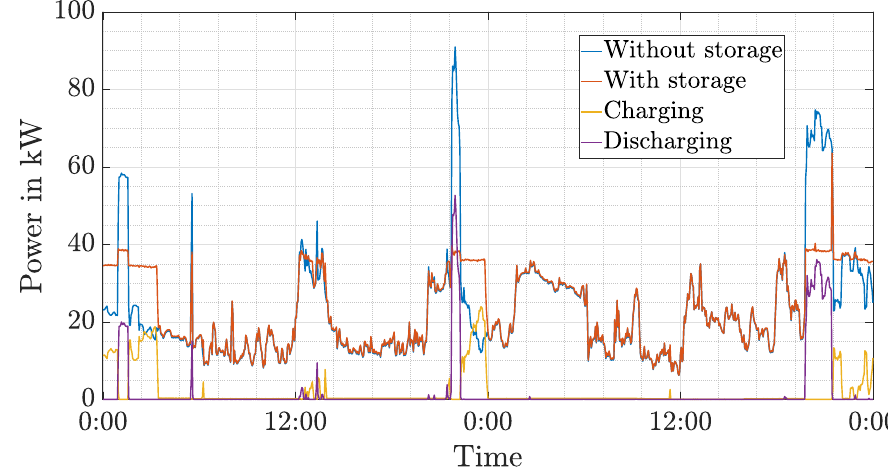
Figure 14. Measurement data for the strategy using measurement